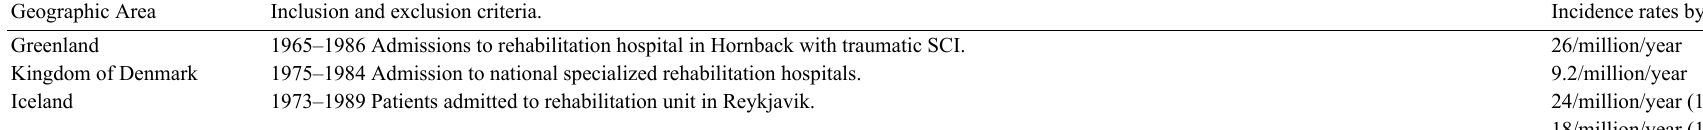
Table 3. Incidence of spinal cord injury in Europe according to his Furlan J.C. study